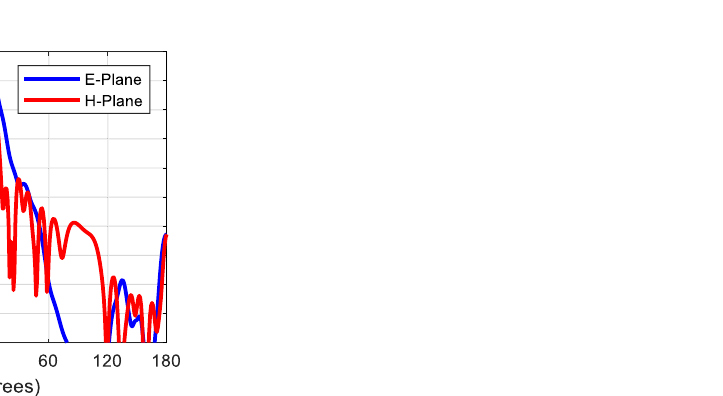
Figure 10. Radiation patterns for the proposed structure in Fig. 7 at 20 GHz, left (H-plane), and right (E-plane).